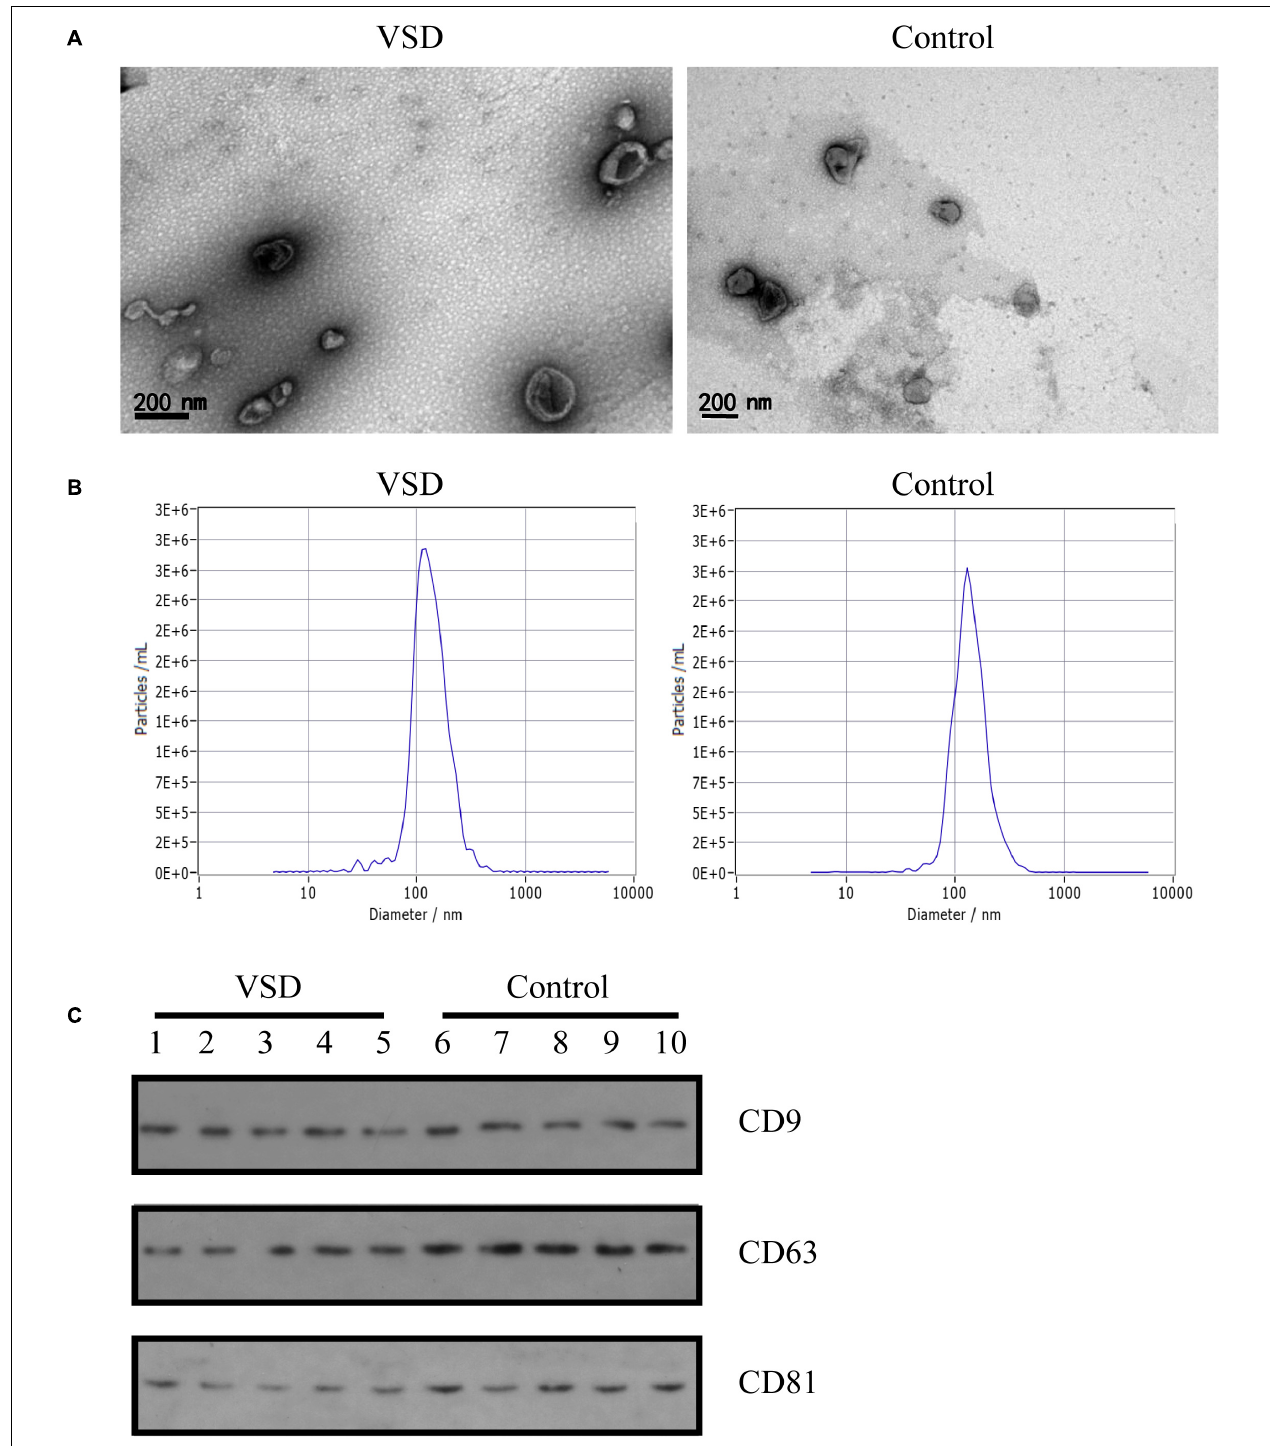
FIGURE 1 | Identification of exosomes from maternal circulation. (A) Transmission electron microscopy results of exosomes from VSD and control samples. Scale bar: 200 nm. (B) Representative Nanoparticle Tracking Analysis (NTA) profiles for one VSD-extracellular vesicle (EV) and one Control-EV sample. (C) Exosomal membrane markers confirmed by western blotting (common markers enriched in exosomes: CD9, CD63, and CD81) in VSD and control groups ( n = 5 per group).